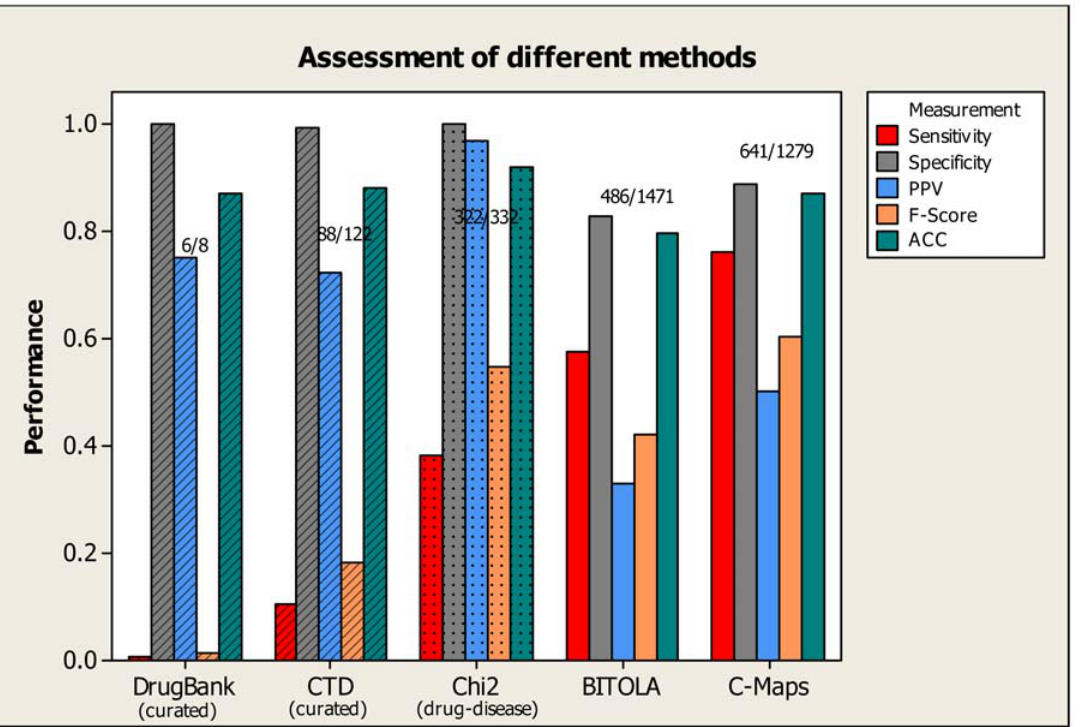
Figure 5. Performance assessment of comparable systems on the task of identifying AD-related drugs. Two curated data sources (DrugBank and CTD) and two computational methods (Chi2 and BITOLA) were selected to compare against the performance of our approach on AD drug identifications. DrugBank and CTD manually curated database content about disease-modifying gene/proteins and drugs. Chi2 is a baseline system using commonly Chi-square statistical method to identify significant co-occurring drug-disease relationships cited in PubMed abstracts. BITOLA (Biomedical Discovery Support System) is a computational system based on natural language processing that can extract drug-protein relation in a disease context. The histogram shows sensitivity, specificity, PPV (positive predictive value), F-score, and ACC (accuracy) of each group. These performance measurements are defined in the Methods section.